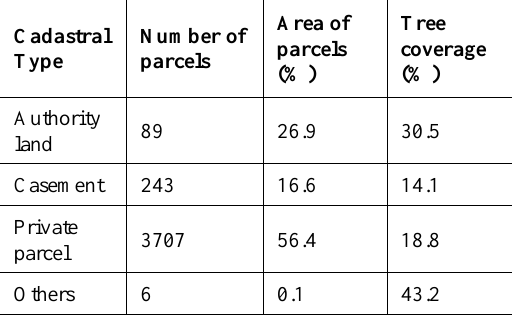
Table 2. Parcel level statistics in different cadastral